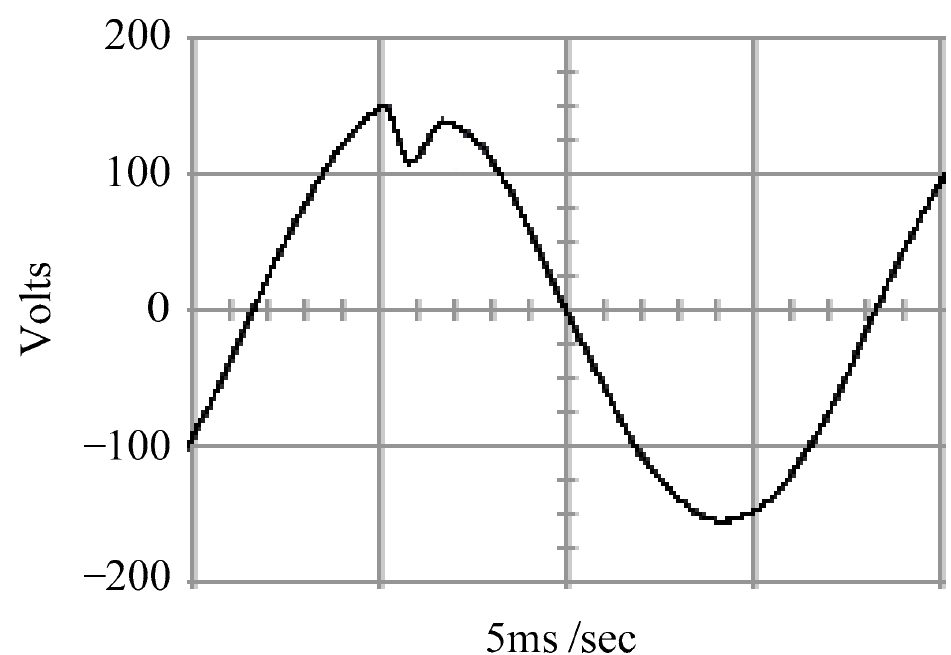
Figure 11. Experimental output voltage with the conventional SMC under stepped load.